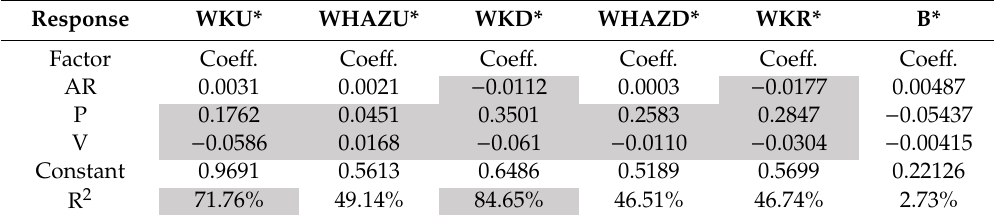
Table 4. Summary of linear models without interactions (e.g., WKU* = 0.9691 + 0.0031 · AR + 0.1762 · P −